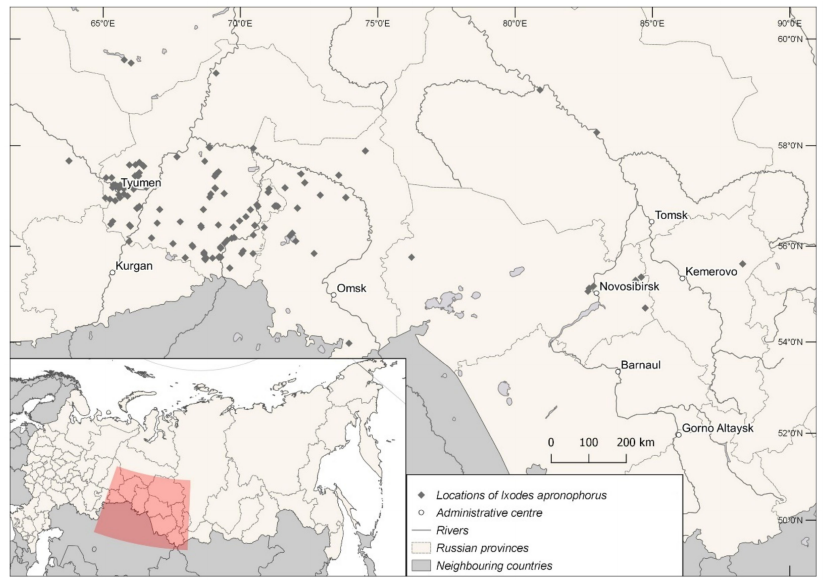
Figure 1. A map of the southern part of West Siberia with localities of Ixodes apronophorus taken from the analyzed archival